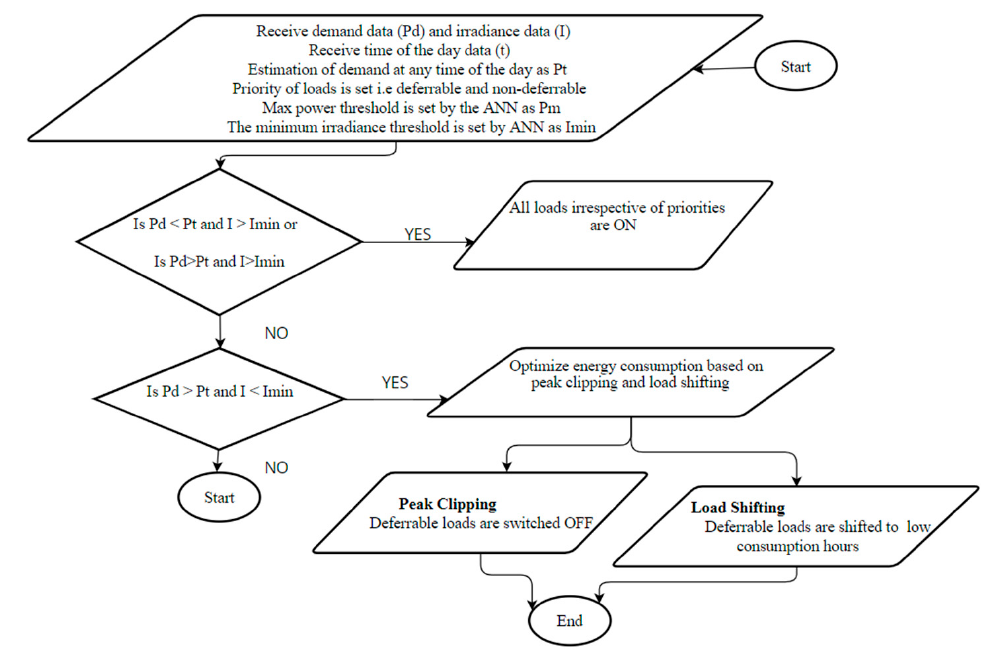
Figure 7. Flow chart of the proposed algorithm.